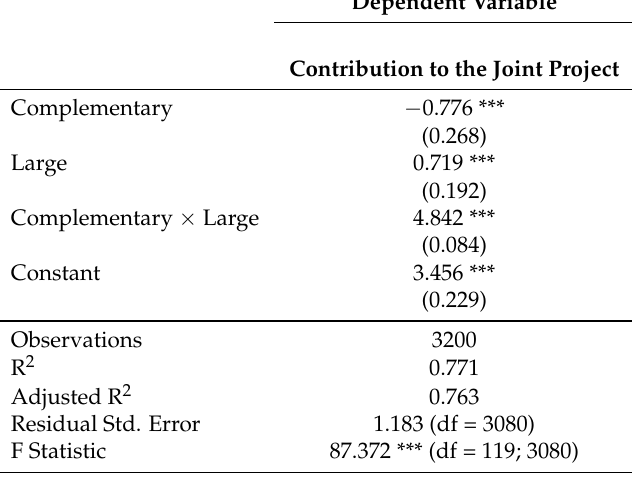
Table 9. Aggregate contribution behavior, pooled